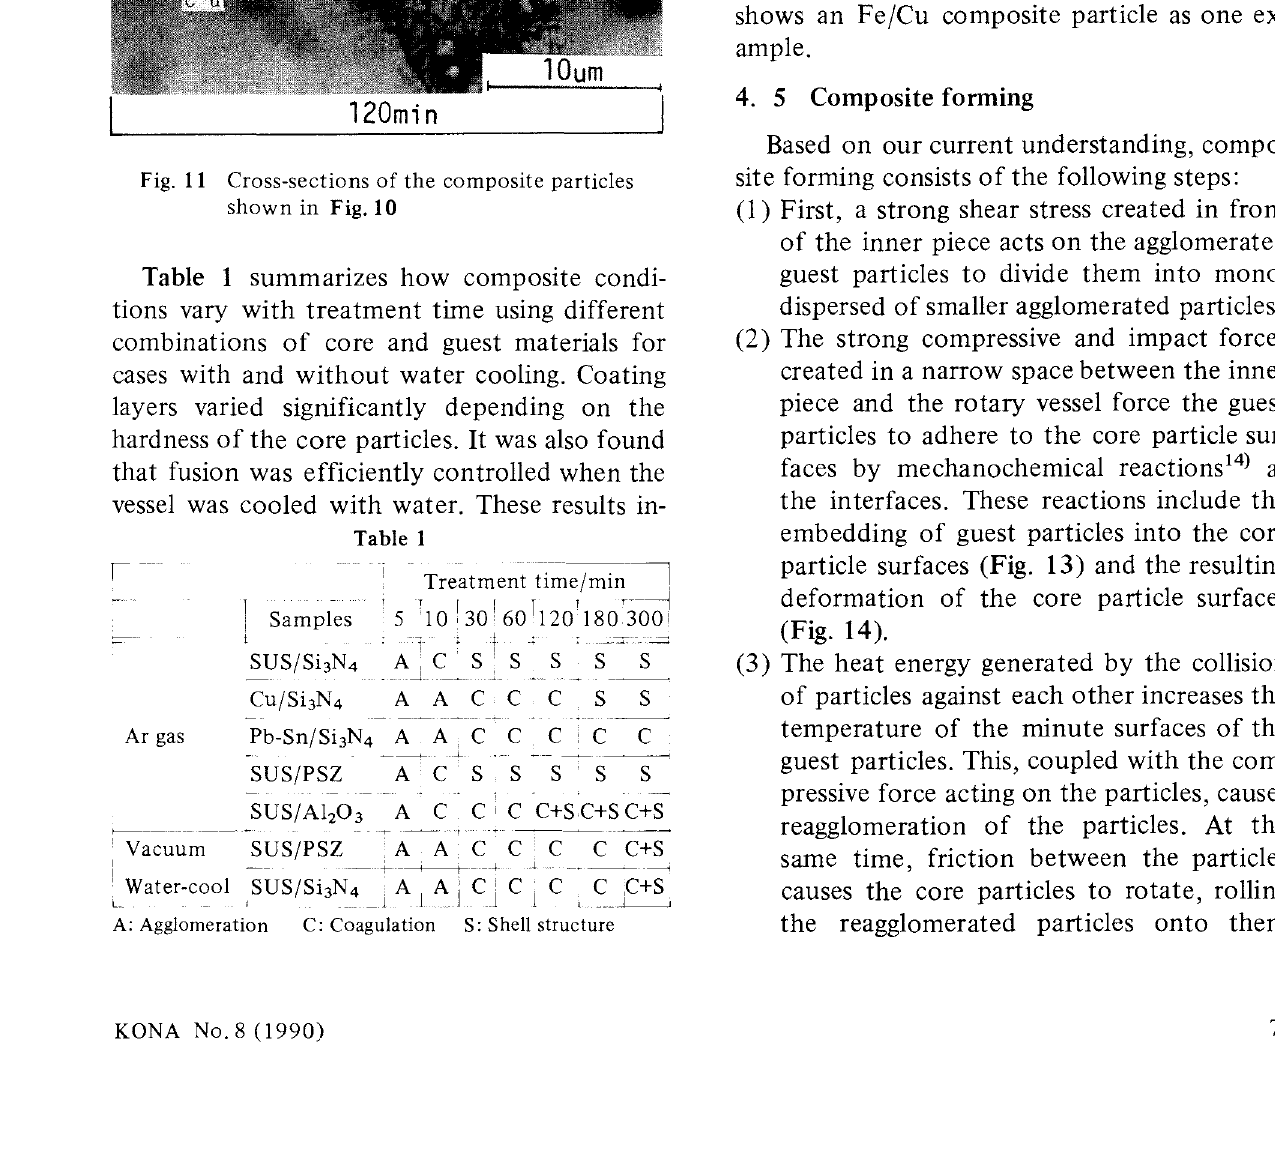
Fig. 11 Cross-sections of the composite particles shown in Fig. 10